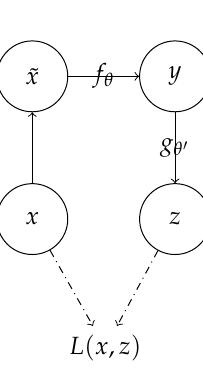
Figure 2. The process of denoising autoencoder (DAE).